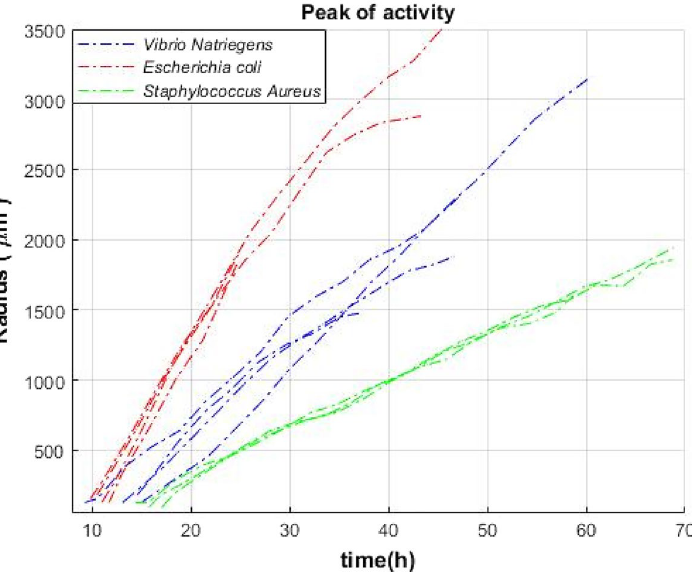
Figure 7. Colony peak activity curves as a function of time for 3–4 V . natriegens (blue), E. coli (red), and S. aureus (green) colonies.